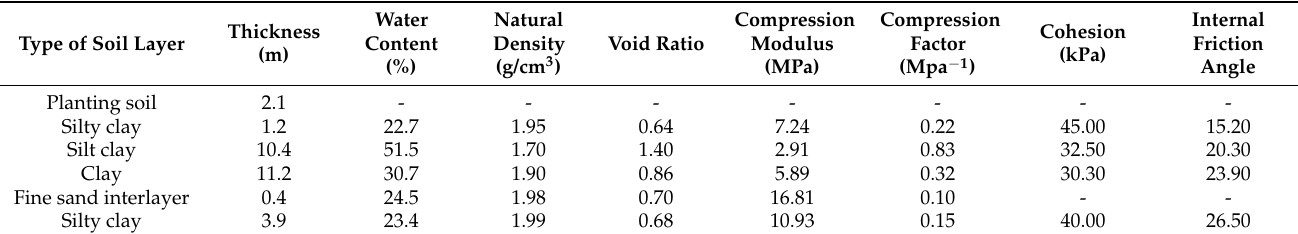
Figure 2. Geographic position of Shen-Jia-Hu expressway. Table 2. Soil parameters.